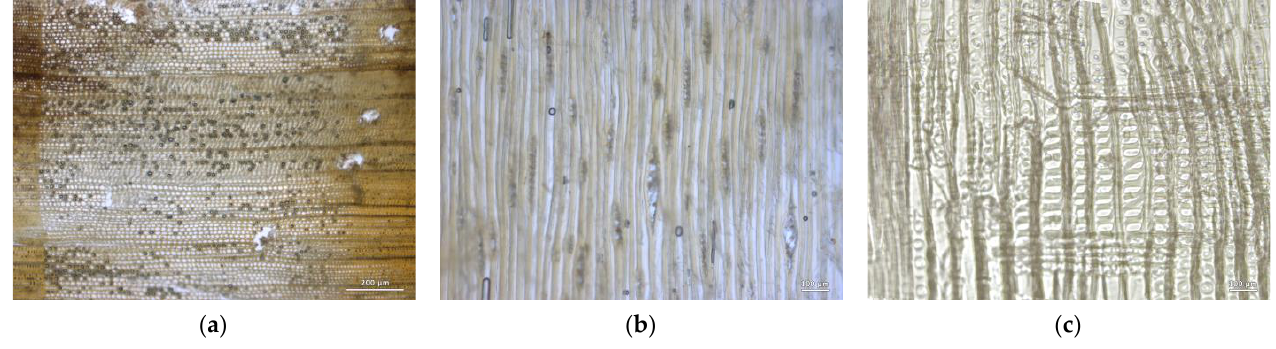
Figure 18. Characteristic sections identified as belonging to the species Pinus sylvestris L: ( a ) Cross- section of sample BU2; ( b ) Tangential section of sample BU2; ( c ) Radial section of sample TE1.